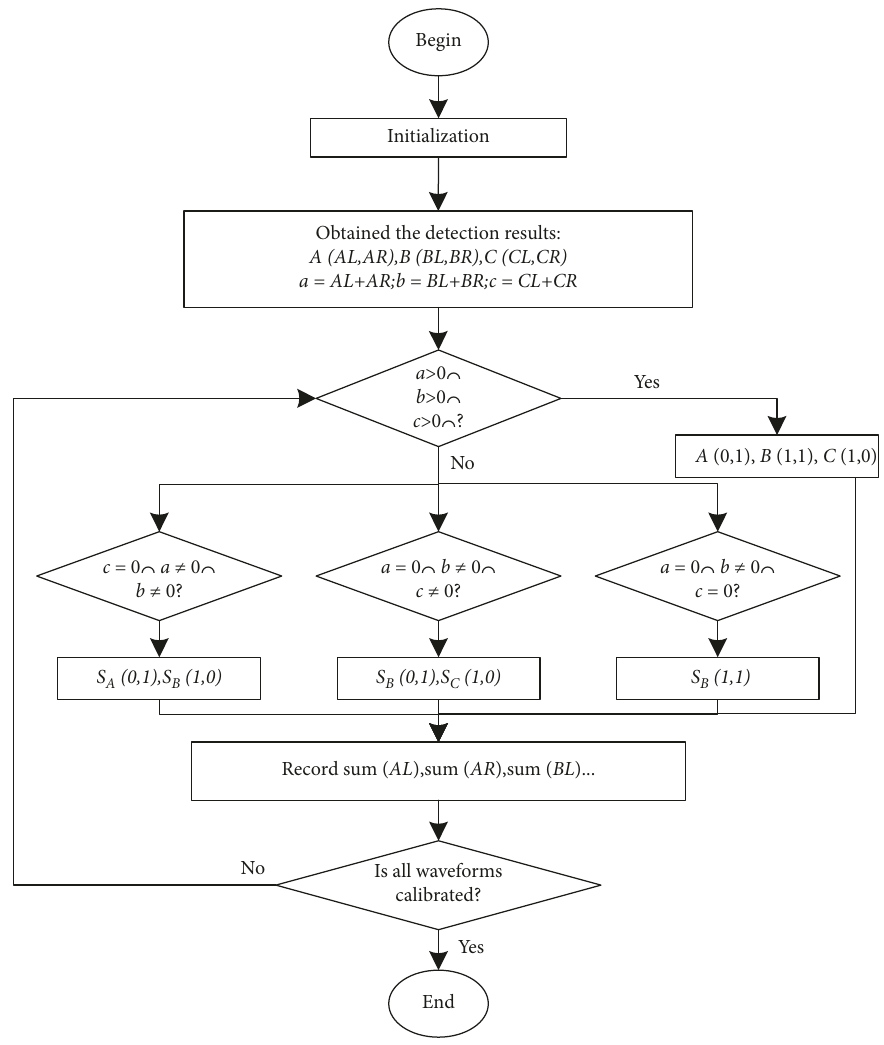
Figure 10: Co-SRS vehicle detection